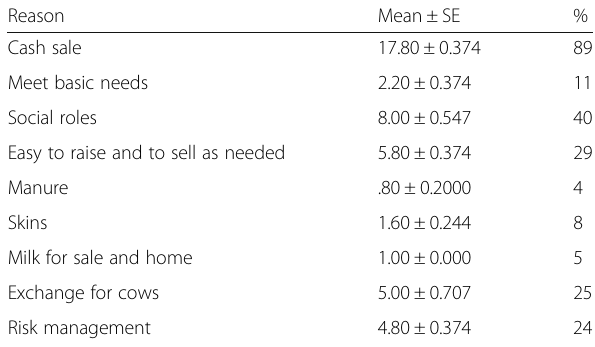
Table 6 Reasons for keeping goats in rural areas of the Nile